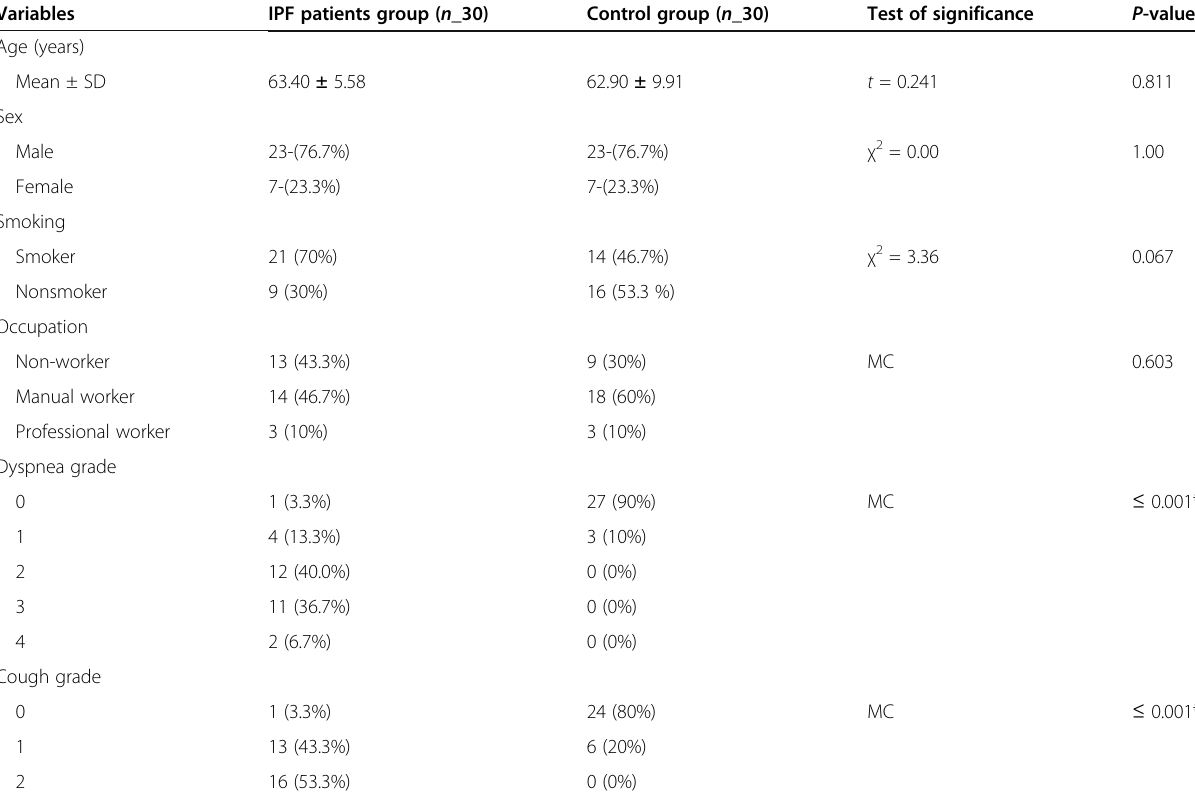
Table 1 Comparison between IPF patients and control groups regarding demographic and clinical data